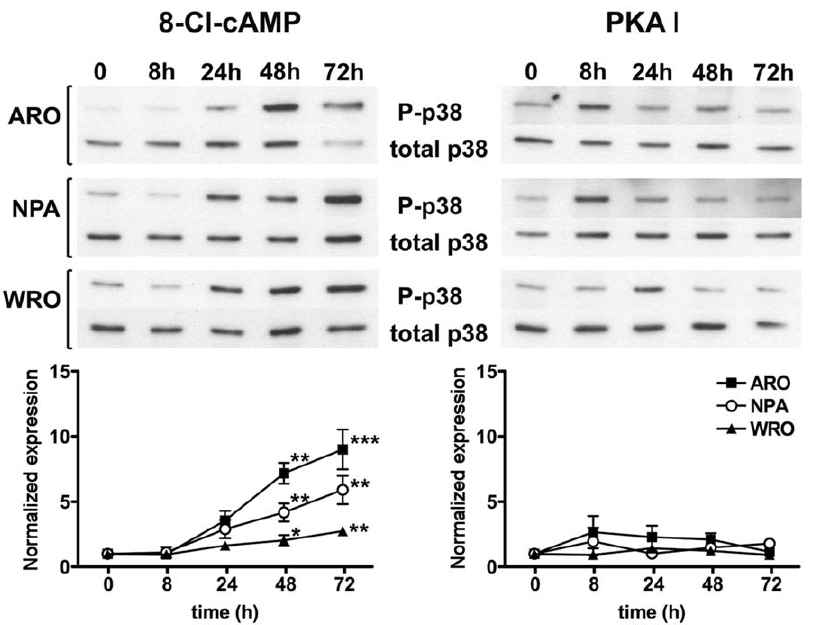
Figure 6. Effect of 8-Cl-cAMP on p38 MAPK phosphorylation. ARO, NPA and WRO cells were treated with 8-Cl-cAMP (100 m M) or the PKA I- selective cAMP analogs (100 m M each) for the indicated periods of time. The levels of phosphorylated and total p38 MAPK were measured by Western blot analysis. Shown are representative Western blots as well as the densitometric analysis of three independent experiments. P-p38/total-p38 ratio is normalized to basal levels. * P , 0.05 vs. basal. ** P , 0.01 vs. basal. *** P , 0.001 vs. basal.